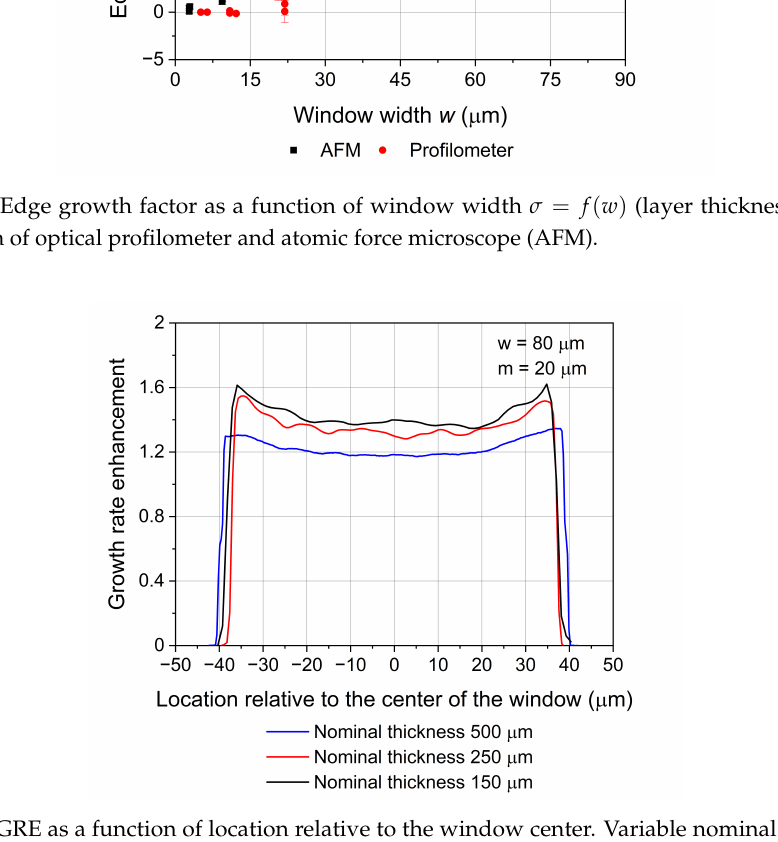
Figure 15. GRE as a function of location relative to the window center. Variable nominal GaN layer thickness, constant window width w = 80 µ m, and mask width m = 20 µ